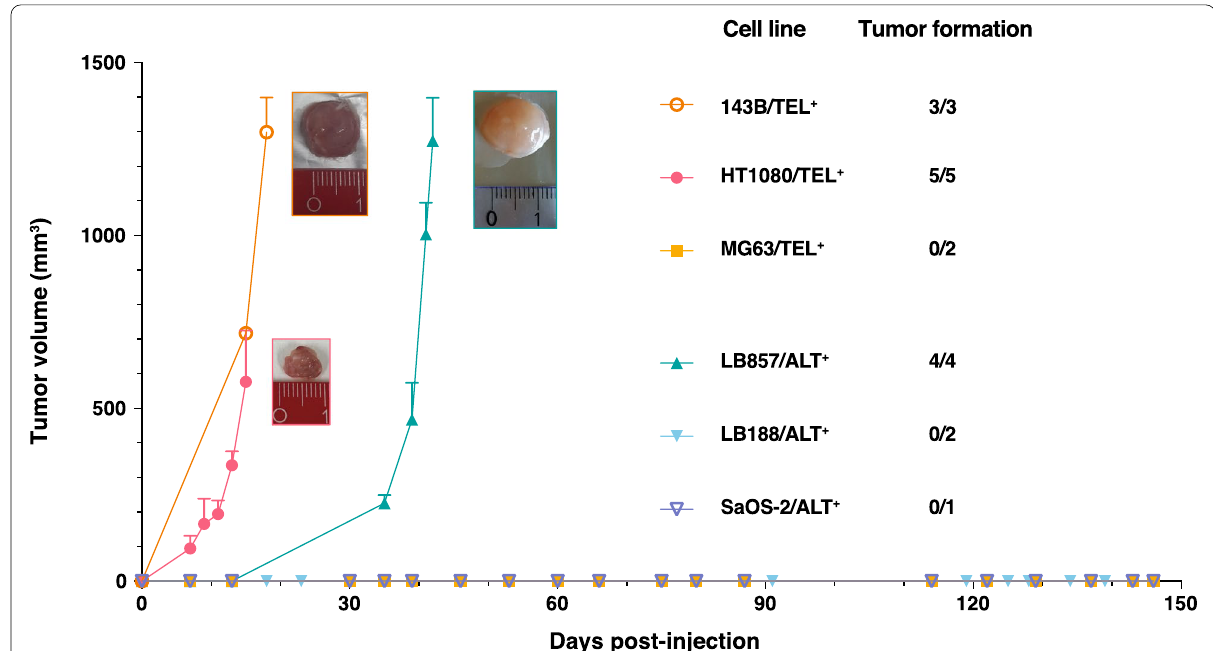
Fig. 1 Establishment of an ALT + tumor xenograft model in NSG mice. Tumor volume was monitored over time with a digital caliper after injection of 10 6 cells in the flank of NSG mice. 143B//TEL + is an osteosarcoma cell line ( n 3); HT1080/TEL + comes from a fibrosarcoma ( n = a myxoid sarcoma cell line ( n 4); MG63/TEL + and LB188/ALT + derive from, respectively, an osteosarcoma and a rhabdomyosarcoma ( n = and SaOS/ALT + is an osteosarcoma cell line ( n 1). Mean SEM. Representative pictures of the xenografts are = +